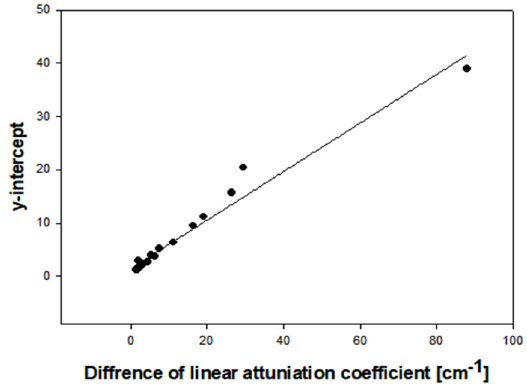
Figure 9. y-intercept(C) of graph for fiber diameter and linear attenuation coefficient.